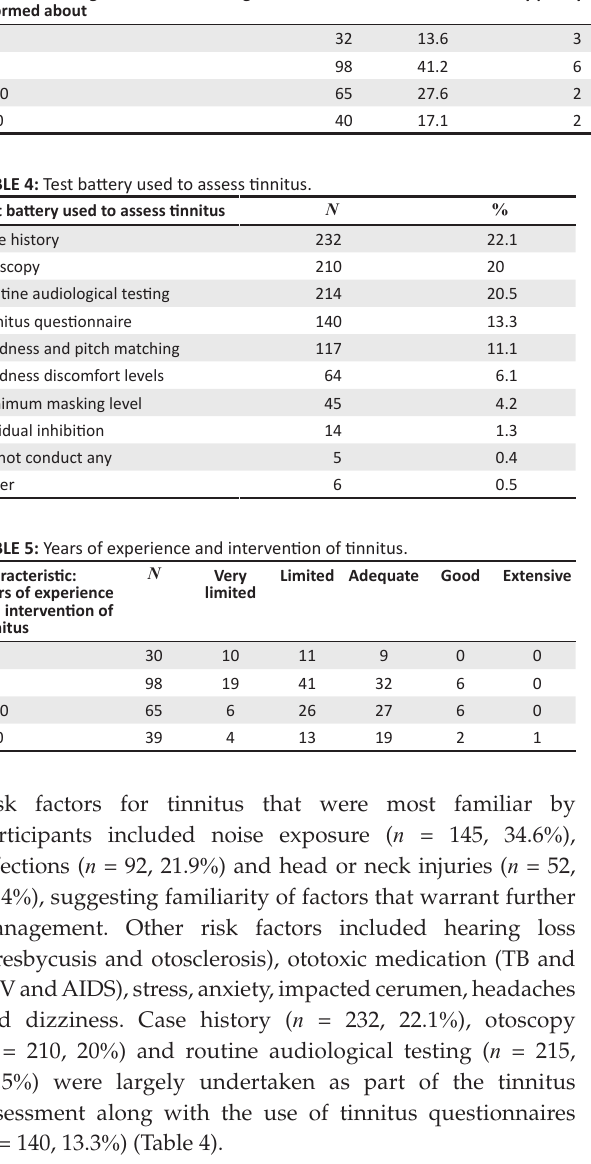
TABLE 3: Years of experience and extent of being informed about assessment. Characteristic: age and extent of being informed about